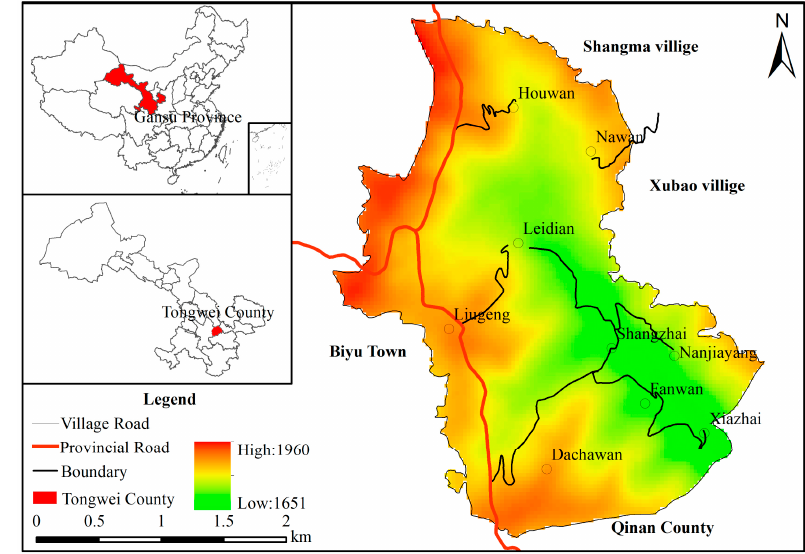
Figure 1. Survey map of the study region.